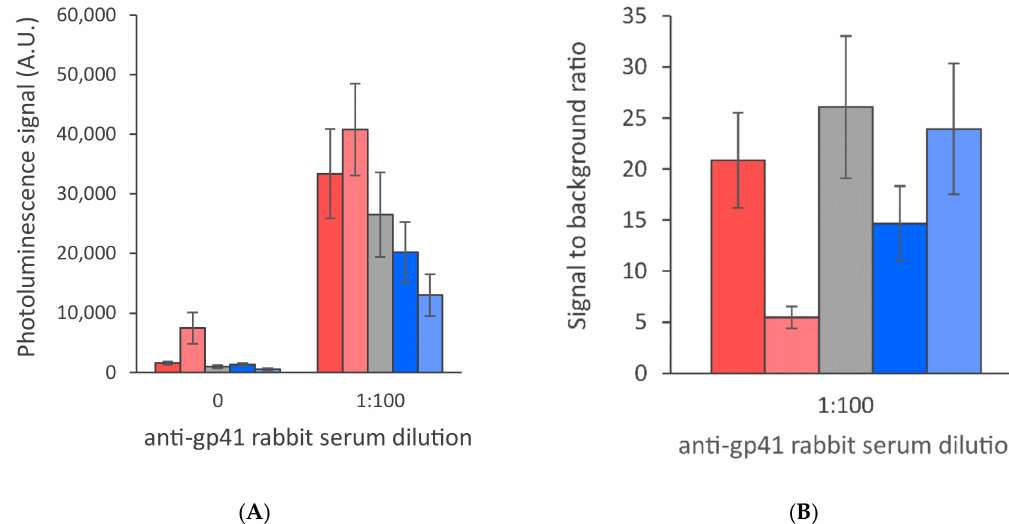
Figure 7. Running buffer comparison. Buffers with pH 7.5 (red), pH 7.5 supplemented with 500 mM NaCl (light red), pH 8.5 (grey), pH 9 (blue) and pH 9.6 (light blue) were compared in the UCNP-LFA. The data are shown as test line maximum photoluminescence signals ( A ) and signal-to-background ratios ( B ). The error bars represent the standard deviation among three replicate strips.